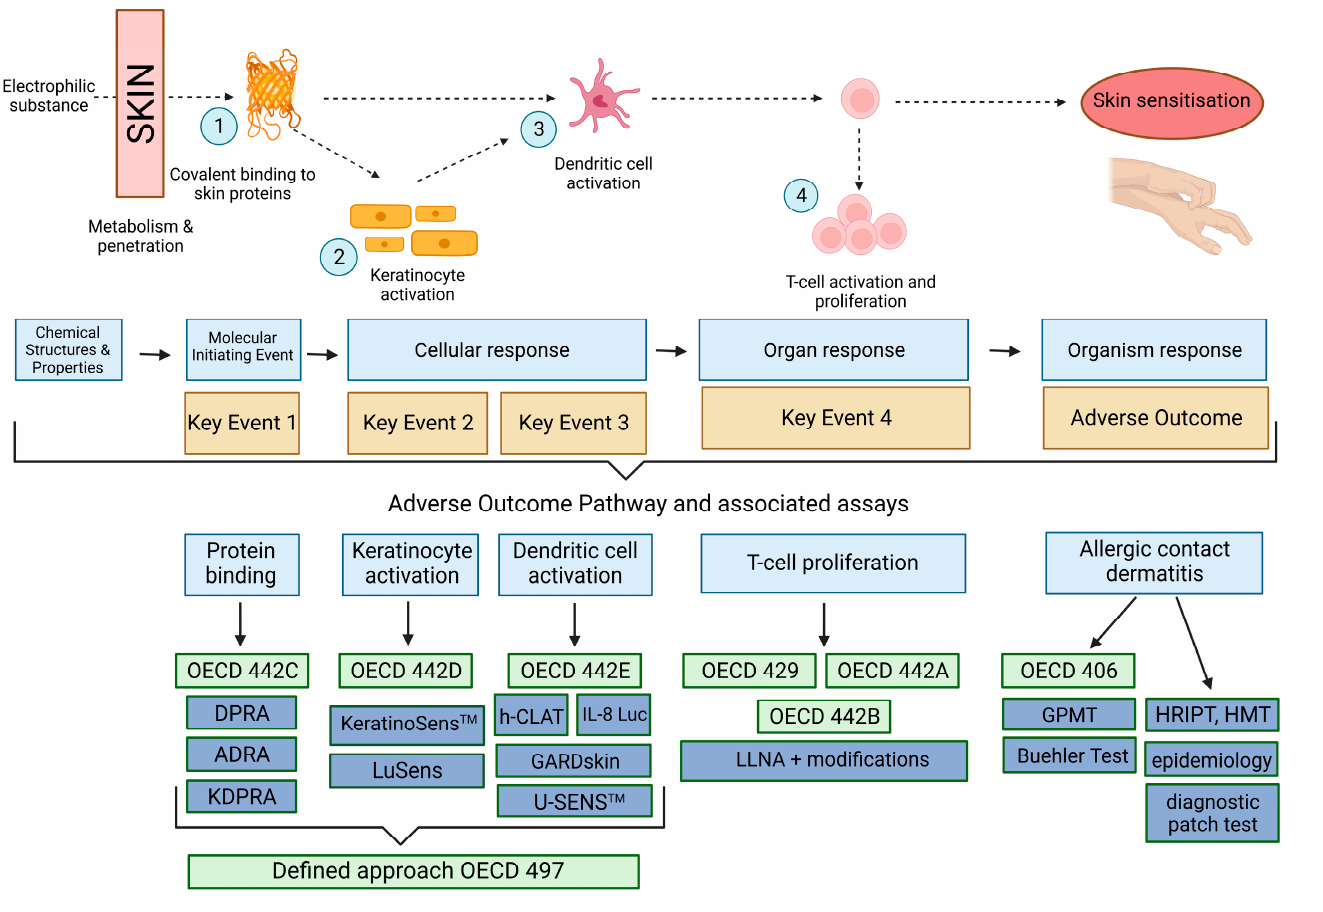
Figure 1. The AOP concept with the main KE and the actual status of validated and scientifically ac- cepted testing methods for skin sensitisation. Created with BioRender.com, accessed on 27 May